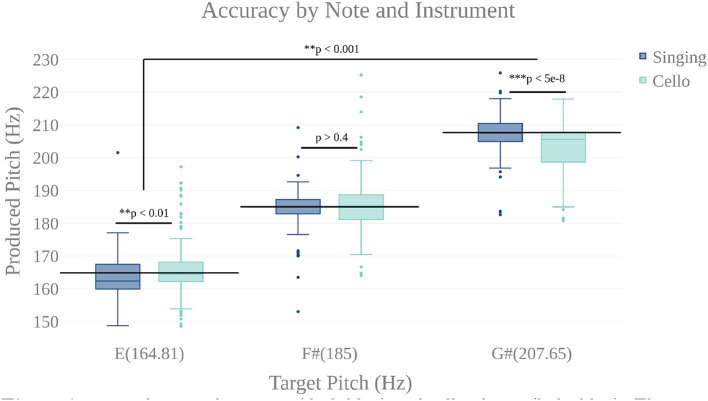
Accuracy by note for singing (dark blue) and cello playing (light blue). There is a highly significant main effect of note, but no main effect of instrument. There is a significant note by instrument interaction showing that participants were slightly flat on the lowest note when singing and slightly flat on the highest when playing the cello. However, mean produced tones were within a quarter tone accuracy (50 cents).